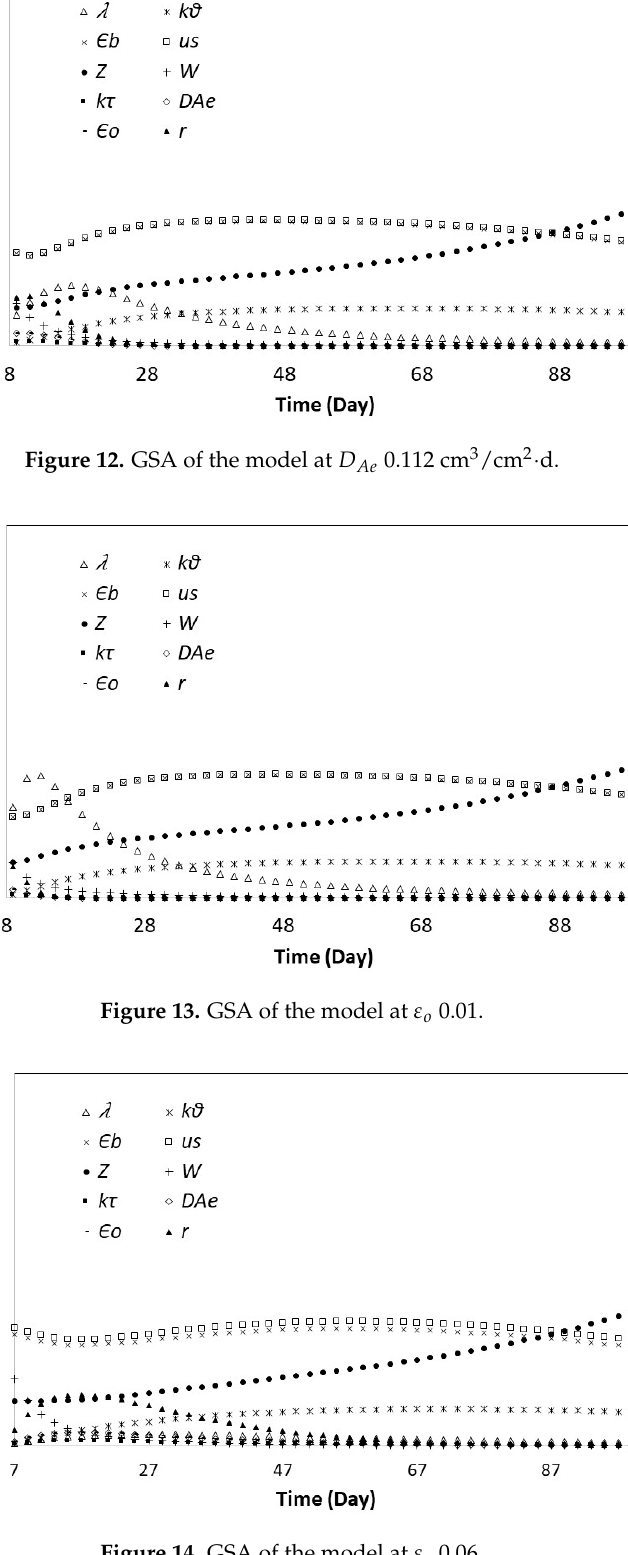
Figure 14. GSA of the model at (cid:2013) (cid:3042) 0.06.